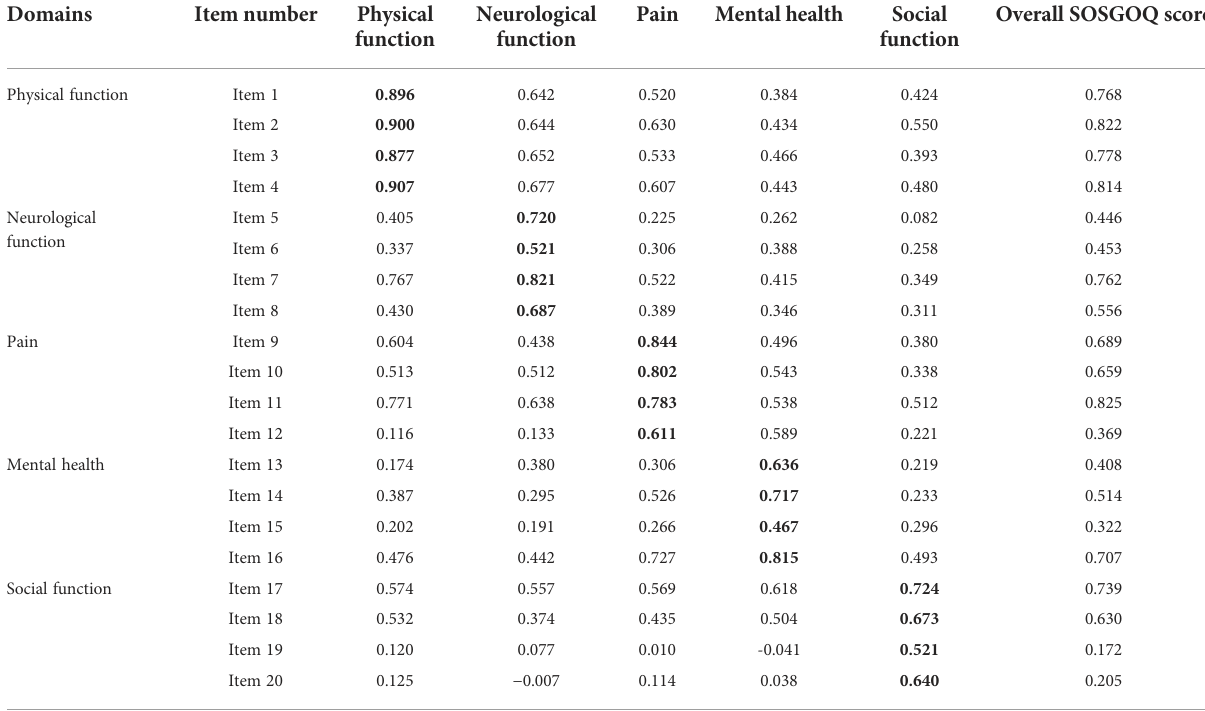
TABLE 3 Multitrait analysis: assessing convergent and divergent validity of individual items with the general fi ve domains of the Spine Oncology Study Group Outcomes Questionnaire (SOSGOQ) and the overall SOSGOQ. Domains